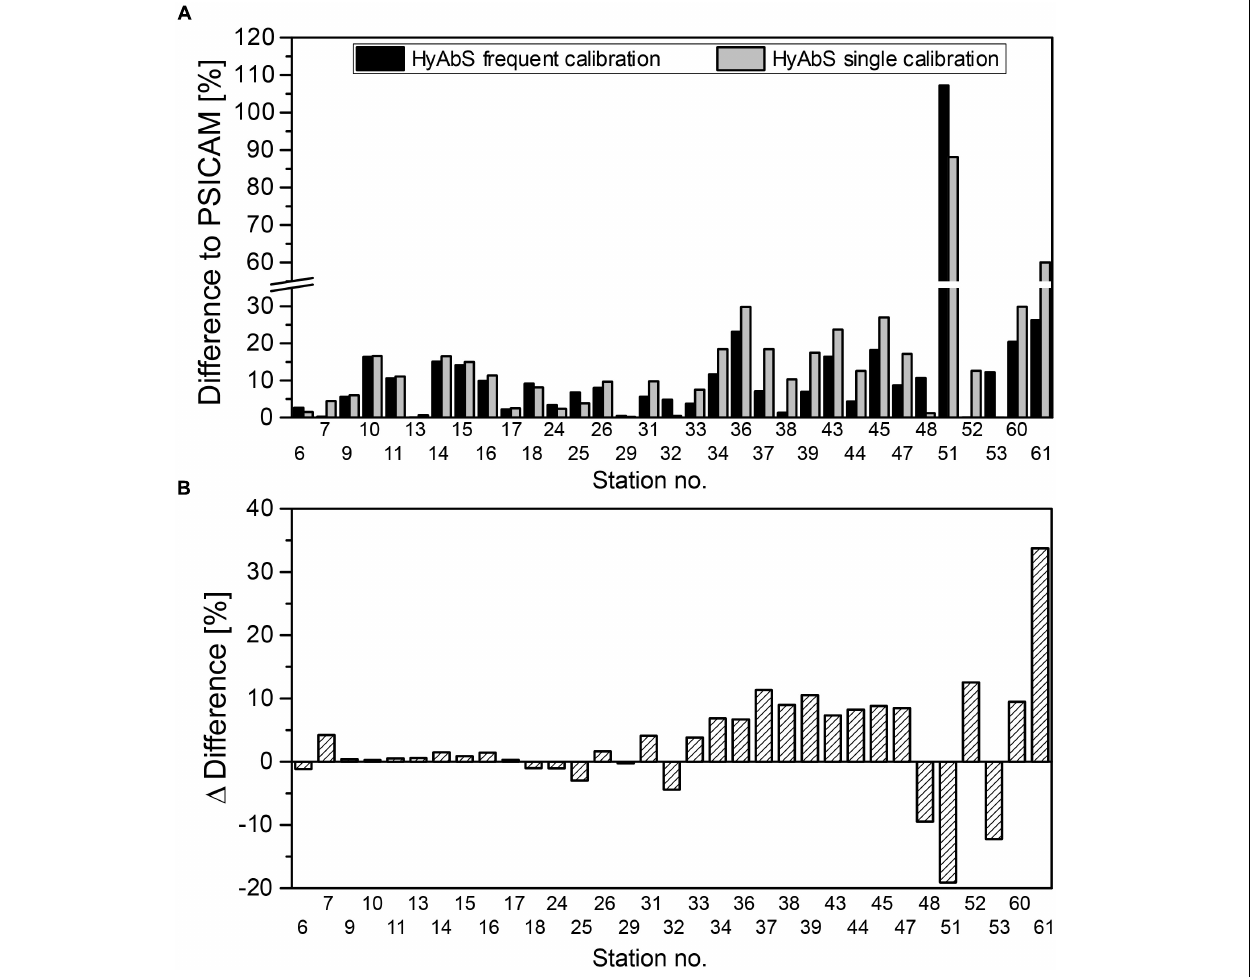
FIGURE 10 | Comparison of PSICAM and HyAbS absorption coefficient measurements at 400 nm. (A) Difference to PSICAM when absorption coefficients were calculated with frequent calibrations or a single calibration, respectively. (B) Difference between both kinds of calculations (Difference PSICAM/HyAbS “single calibration” minus difference PSICAM/HyAbS “frequent